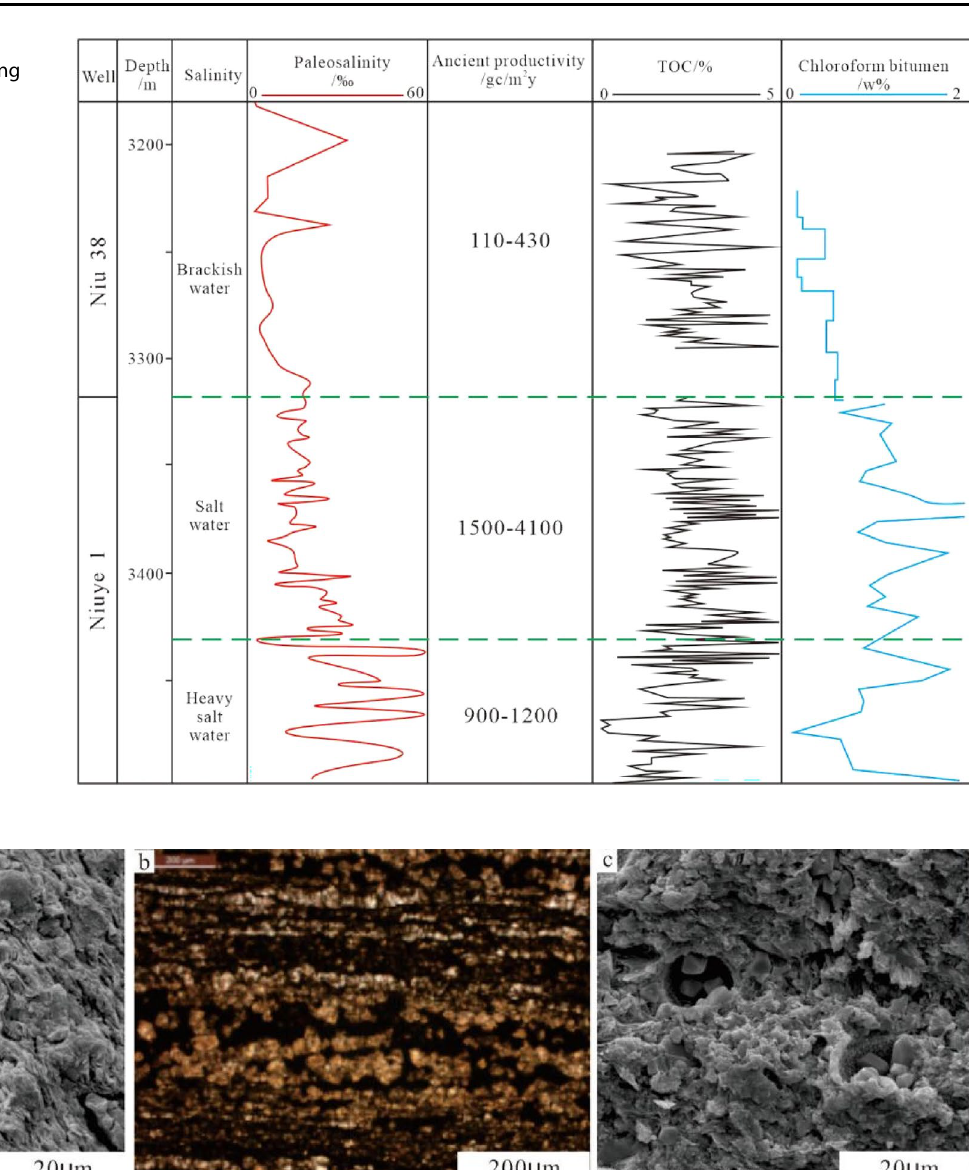
between calcite crystals, c Well Luo 69, 2992.60 m, with intergranu- lar micropores of calcite, clay and